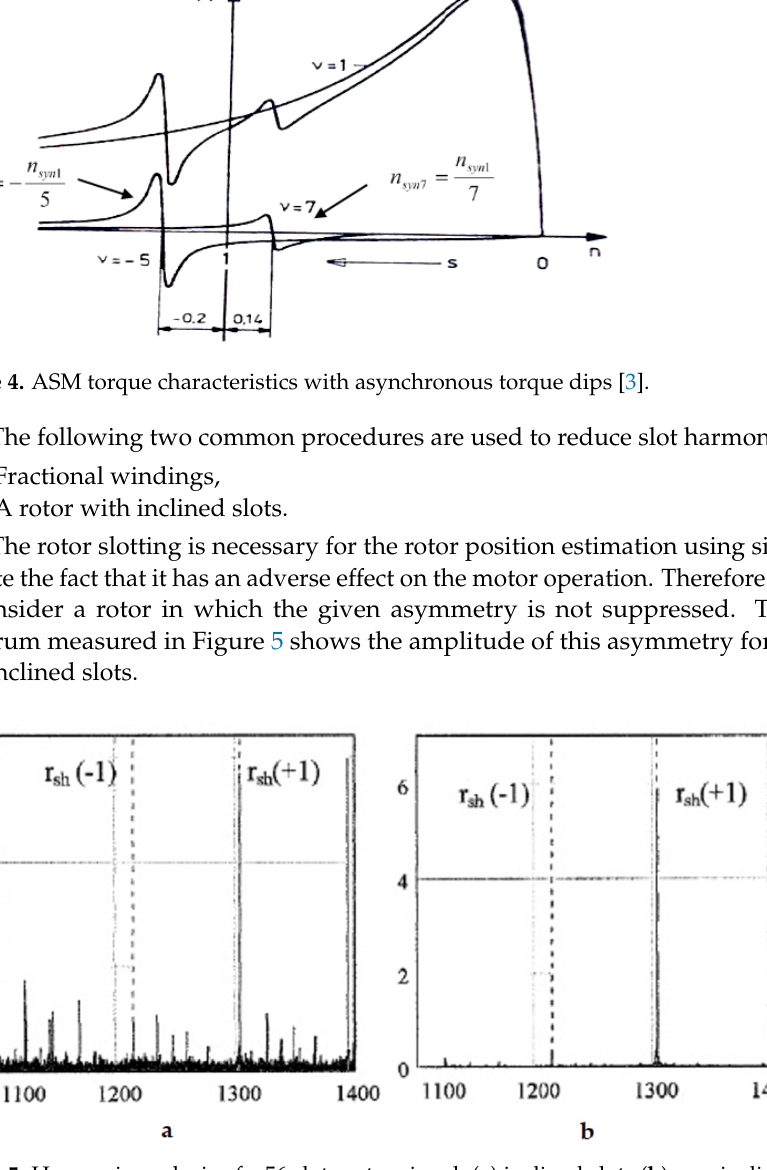
Figure 5. Harmonic analysis of a 56 slot motor signal. ( a ) inclined slots ( b ) non-inclined slots [3] . The theoretical basis was followed when creating the inductance change due to the rotor slotting in the simulation model of the asynchronous motor. The value of the stator inductance LS is a sine (cosine) periodic function of the rotor position with a frequency dependent on the number of rotor teeth Nr., as shown in the Figure 6. The voltage